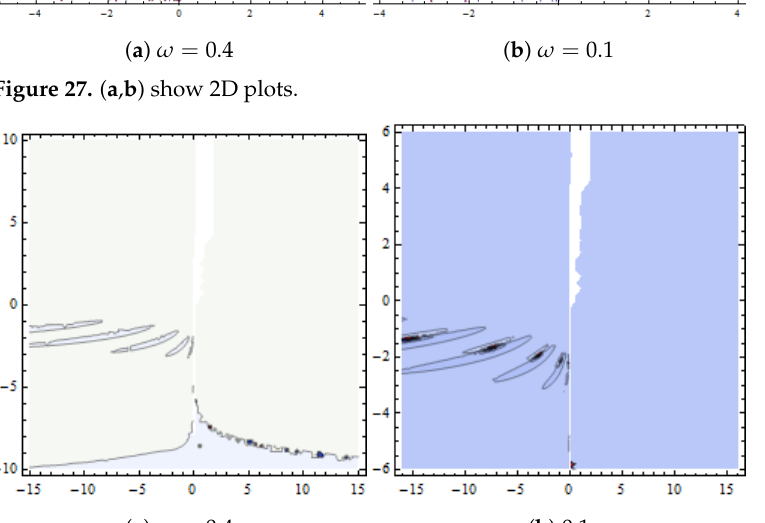
Figure 27. ( a , b ) show 2D plots.